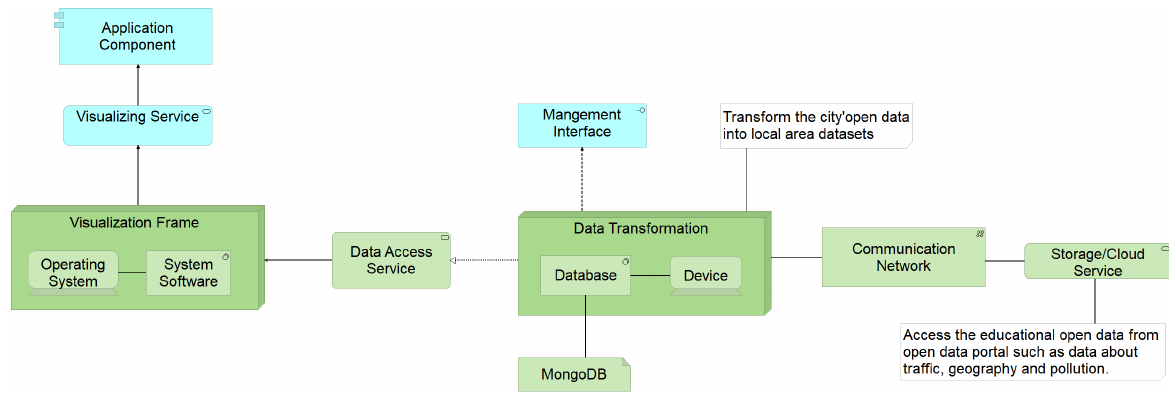
Figure 6. Technology layer requirements model